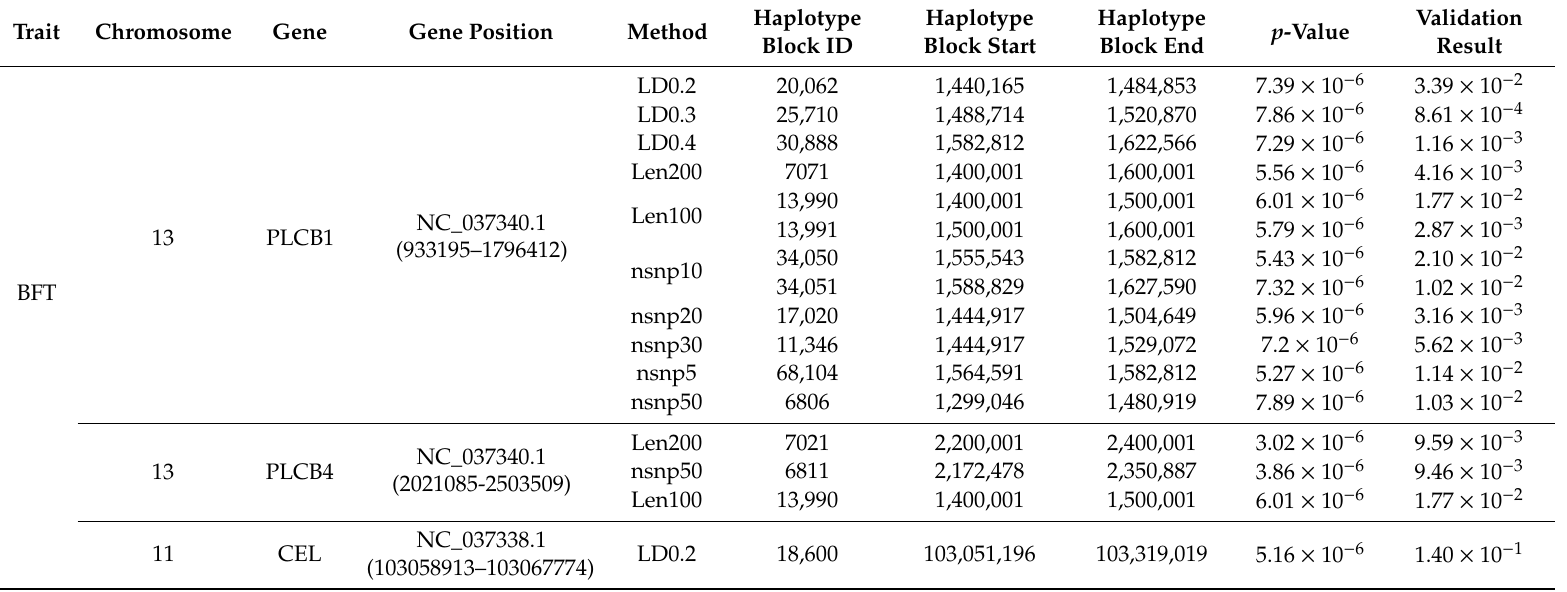
Table 4. Candidate genes identified by di ff erent haplotype blocks constructed by three di ff erent methods and their p -value obtained by GEMMA software.